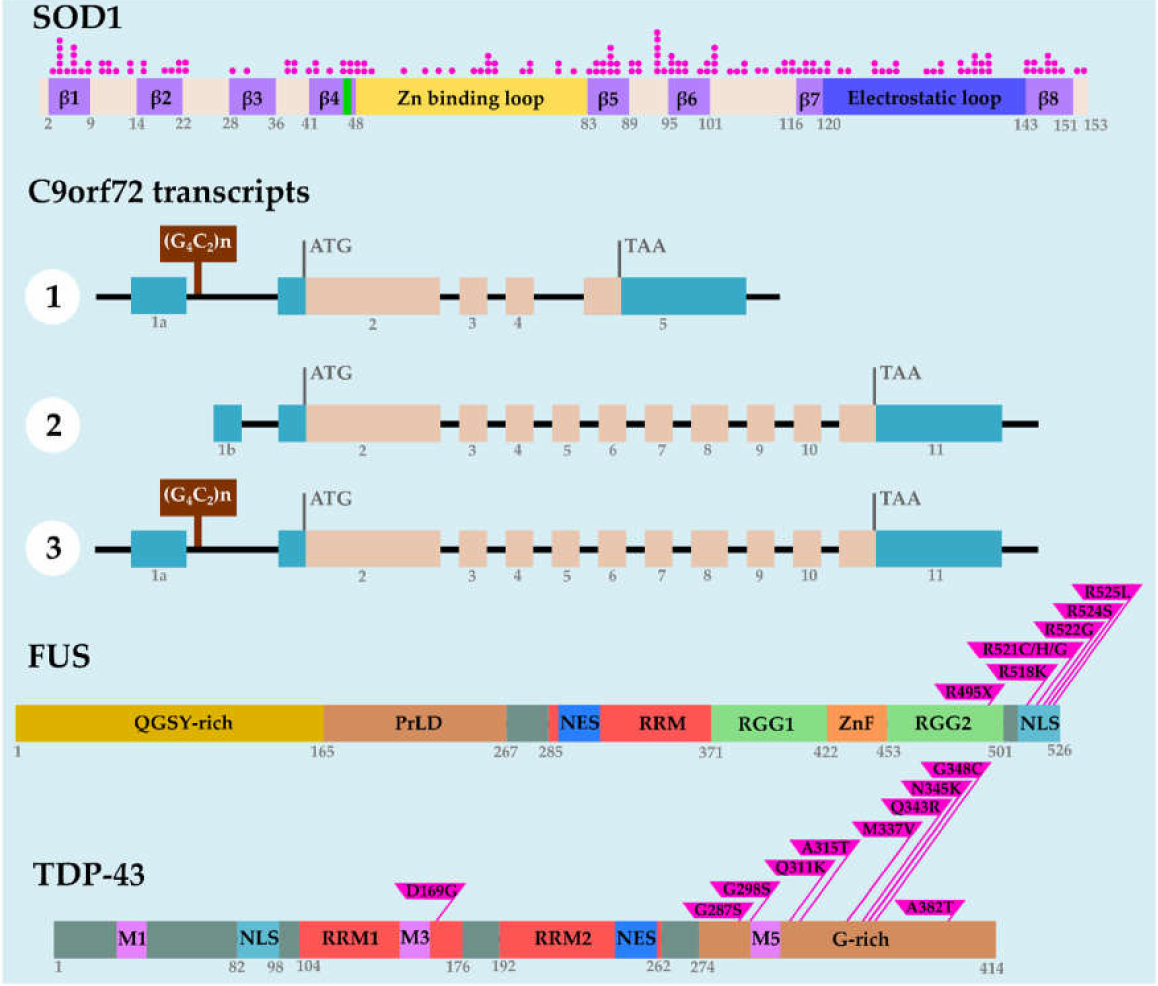
Figure 3. Structure of chromosome 9 open reading frame 72 (C9orf72) transcripts and SOD1, fused in sarcoma (FUS), and TAR DNA-binding protein (TDP)-43 proteins. The human SOD1 protein is composed of eight beta-strands (in purple) and connecting loops. The Cu-binding region, the Zn-binding loop, and the electrostatic loop are represented in green, yellow, and blue, respectively. ALS-associated missense mutations are located throughout the protein and are listed vertically in pink dots. The human C9orf72 gene produces three variants. The (G 4 C 2 ) hexanucleotide repeat expansion (HRE) is located in the first intron of variants 1 and 3, and in the promoter region of variant 2. The human FUS protein constitutes a N-terminal glutamine/glycine/serine/tyrosine-rich region (QGSY-rich in dark yellow), a prion-like domain (PrLD in brown), a nuclear export signal (NES in blue), a RNA recognition motif (RRM in red), two arginine/glycine-rich regions (RGG1 and RGG2 in green), a zinc finger domain (ZnF in orange), and a C-terminal non classical nuclear localization signal (NLS in cyan). Most ALS-related mutations are found in the C-terminal NLS region of FUS protein. The human TDP-43 protein carries three mitochondrial localization domains (M1, M3, and M5 in pink), a nuclear localization signal (NLS), two RNA recognition motifs (RRM1 and RRM2 in red), a nuclear export signal (NES), and a glycine-rich domain (G-rich in brown). The ALS-associated mutations described in the review are